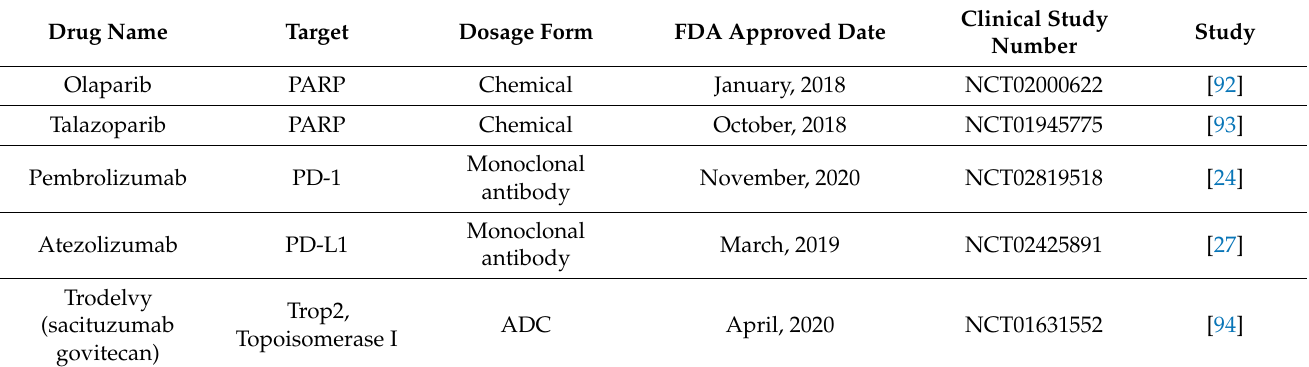
Table 2. Drugs approved by FDA for patients with